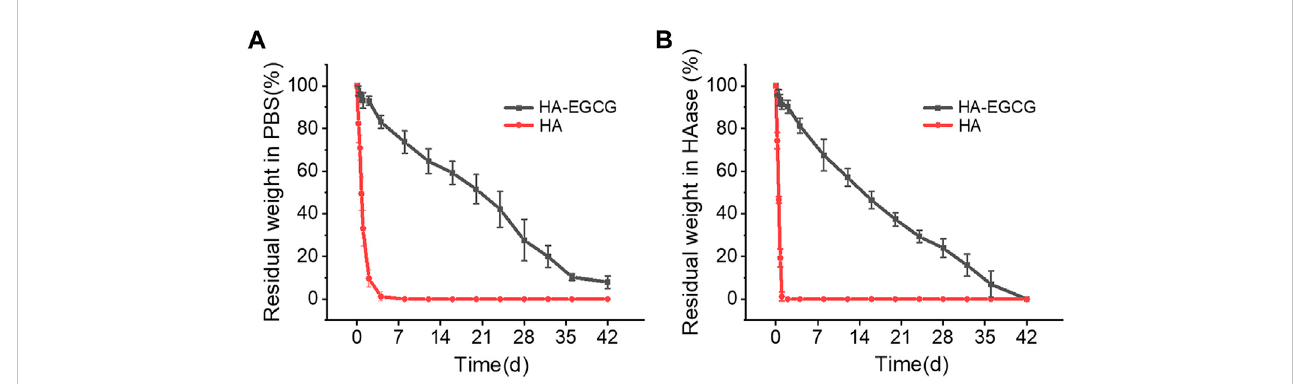
FIGURE 3 Degradation pro fi les of HA-EGCG hydrogel in PBS and HAase. (A) Degradation rate of the HA-EGCG hydrogel in PBS (n = 3). (B) Degradation of HA- EGCG hydrogel in PBS containing 15 units/mL HAase (n =